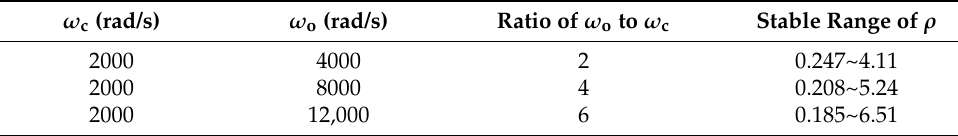
Figure 6. Root locus diagram of Table 1. Stable range of ρ with different ω o and ω c